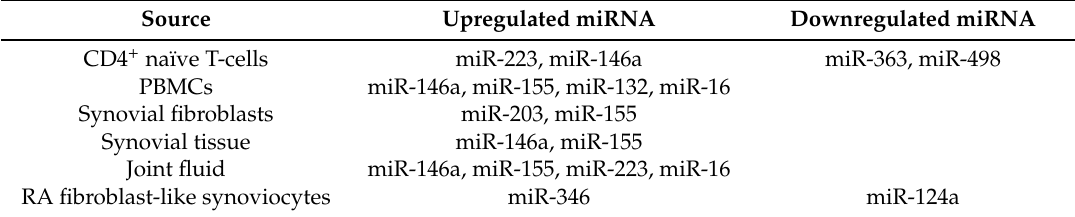
Table 3. Aberrant micro-RNA expression in